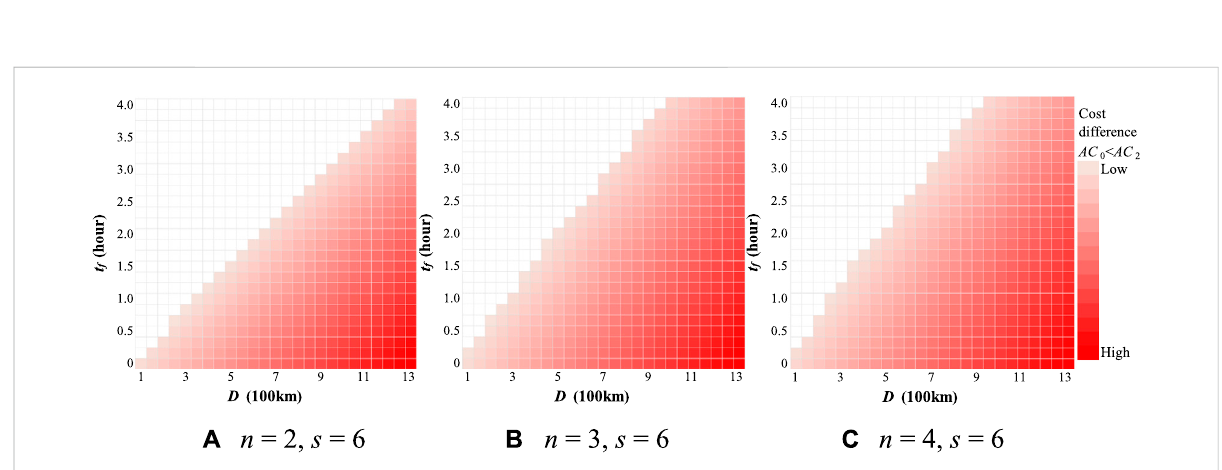
FIGURE 7 CostcomparisonbetweenCase0(singletruck)and2(truckplatooning)foradifferentnumberofplatoonedtrucks( n ). (A) n =2, s =6 (B) n =3, s = 6 (C) n = 4, s = 6.